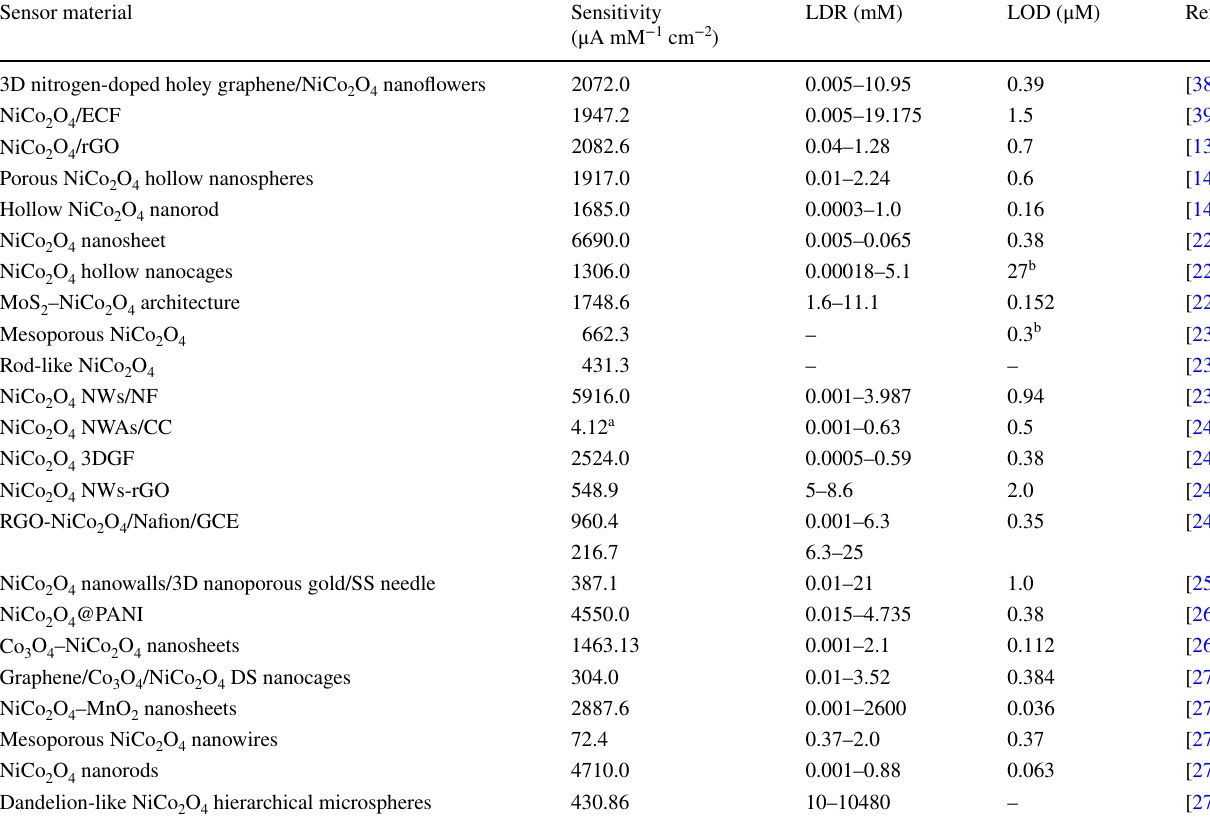
Table 1 Electrochemical sensing parameters for various NiCo 2 O 4 -based modified electrodes toward